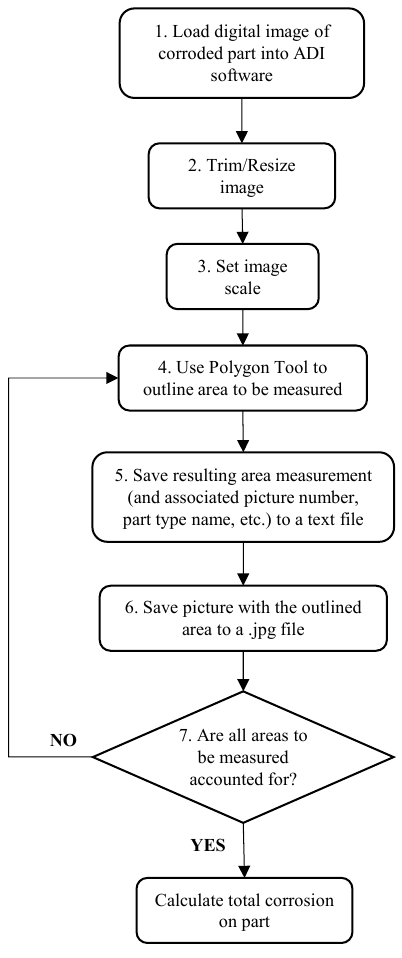
Figure 5. Flowchart of process used to measure corrosion in digital images of vehicle parts, using ADI software.